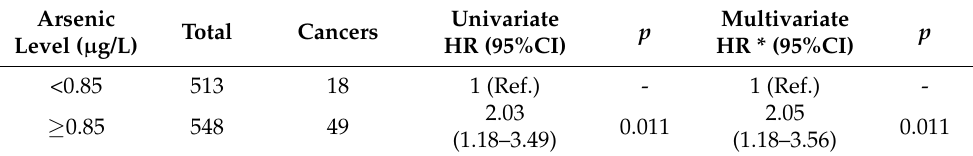
Table 3. Hazard ratios (HR) for breast cancer stratified by the median total blood arsenic level ( µ g/L) n =